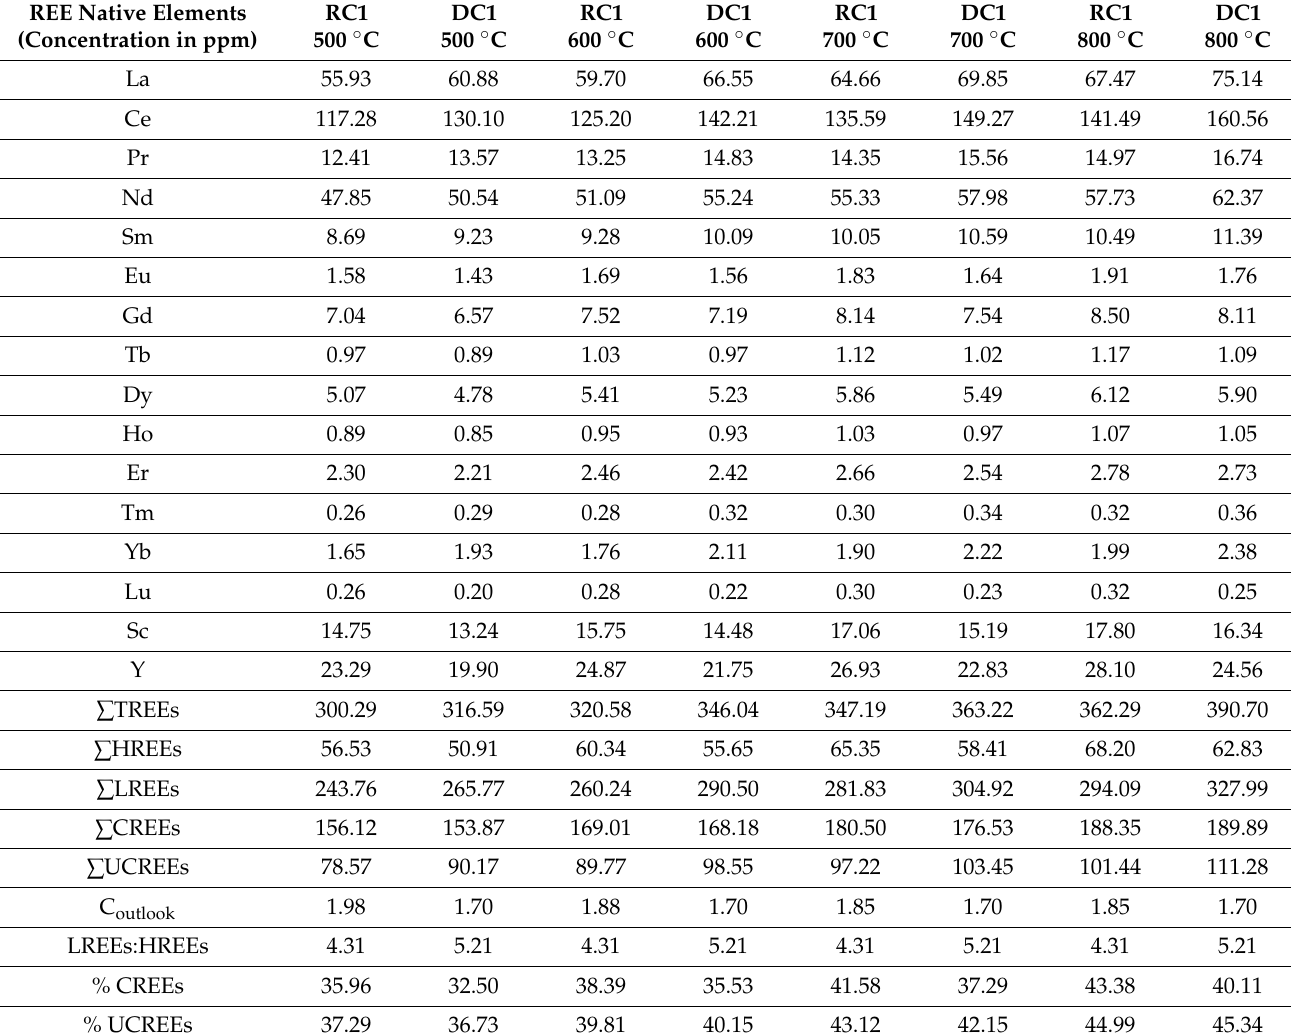
Table 2. ICP-MS results for individual REE contents and the TREEs, outlook coefficient (C outlook ), and REE ratios for the calcined coal